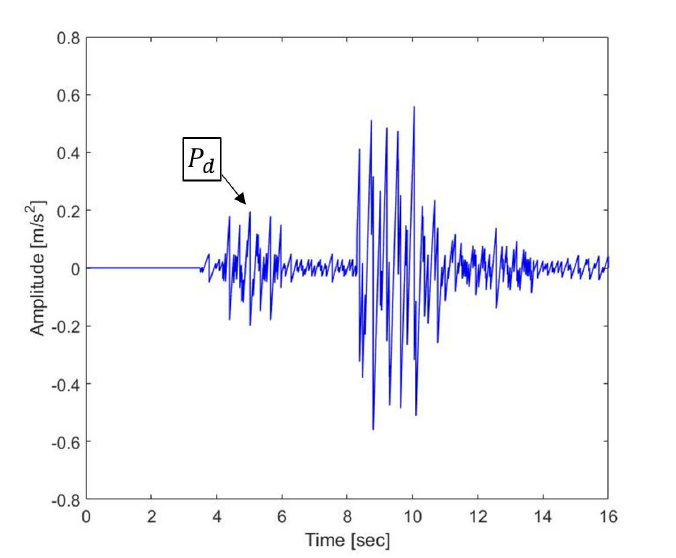
Figure 4. Detection of peak acceleration amplitude ( P d ) using a heterodyne laser